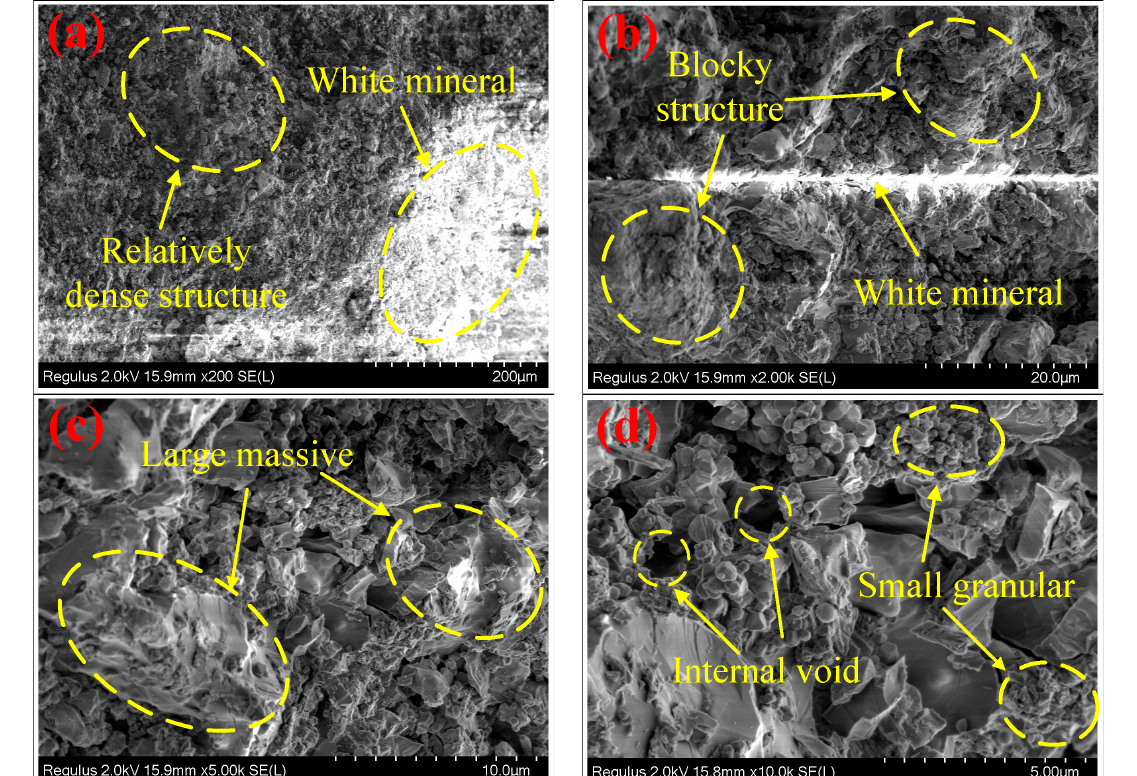
Figure 2. Results of the SEM analysis of the ceramsite. In the figure, ( a , b ) represent the overall appearance of the interior of ceramsite under relatively small magnification, and ( c , d ) represent the local appearance of the interior of ceramsite under relatively large magnification.